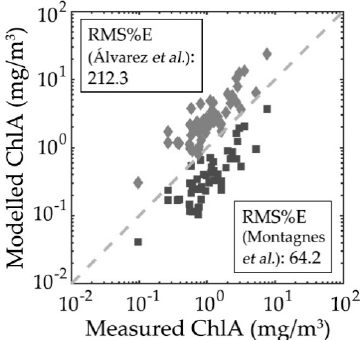
Figure 8. Comparison of modelled vs. measured ChlA. ChlA values calculated using the Montagnes et al. [11] model and the Á lvarez et al. [13] model are represented by dark grey squares and light grey diamonds respectively. The dashed grey line indicates the 1:1